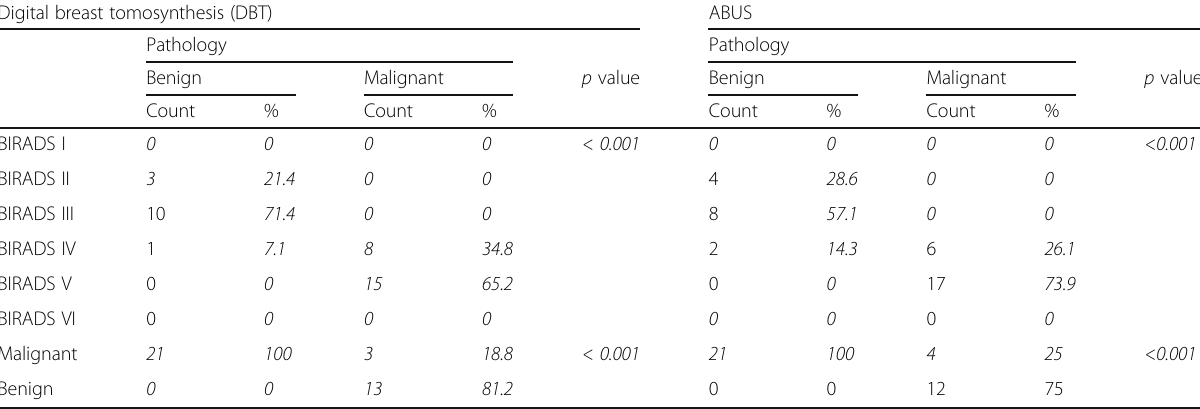
Table 5 Breast masses classification according to BIRADS score system Digital breast tomosynthesis (DBT) ABUS Pathology Pathology Benign Malignant p value Benign